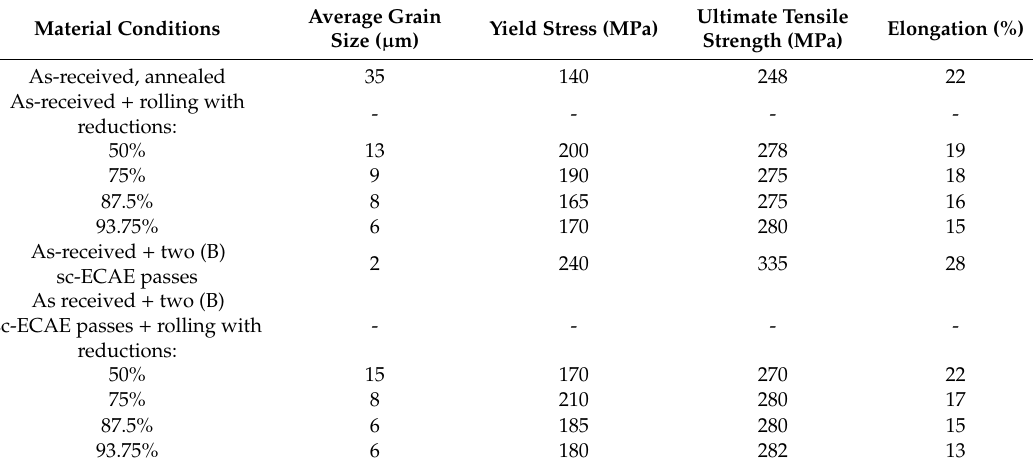
Table 3. Grain size and tensile properties of magnesium alloy